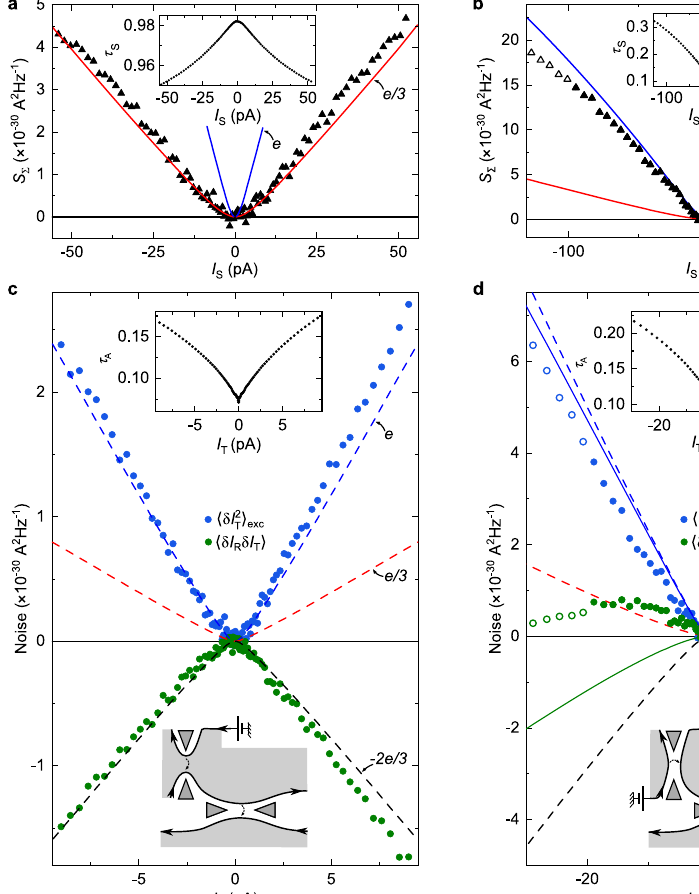
reduced signal).Blueand green symbolsinthe mainpanelsshow, respectively,the excess auto-correlations of the transmitted current and the cross-correlations between transmitted and re fl ected currents. Open symbols in panels ( b ) and ( d ) correspondtodatawith τ S ≥ 0.3,forwhichthesourcenotablydeviatesfromtheSBS regime.Dashedblue,redandblacklinesrepresent,respectively,a1 e shotnoise,a e / 3 shot noise and − (2/3)times the 1 e shotnoise all inthe dilute incident beamlimit. Continuous lines in ( d ) display the noninteracting electrons ’ predictions valid at any τ A,S for h δ I 2 T i (blue)and 〈 δ I R δ I T 〉 (green),calculatedusingthemeasured τ A,S (see Eqs. (6) and (7) in